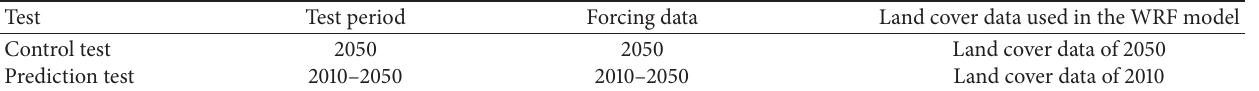
Figure 1: Spatial pattern of cultivated land in the base year of 2010 (a) and its possible changes in future (b) in India. Table 1: Description of the experimental